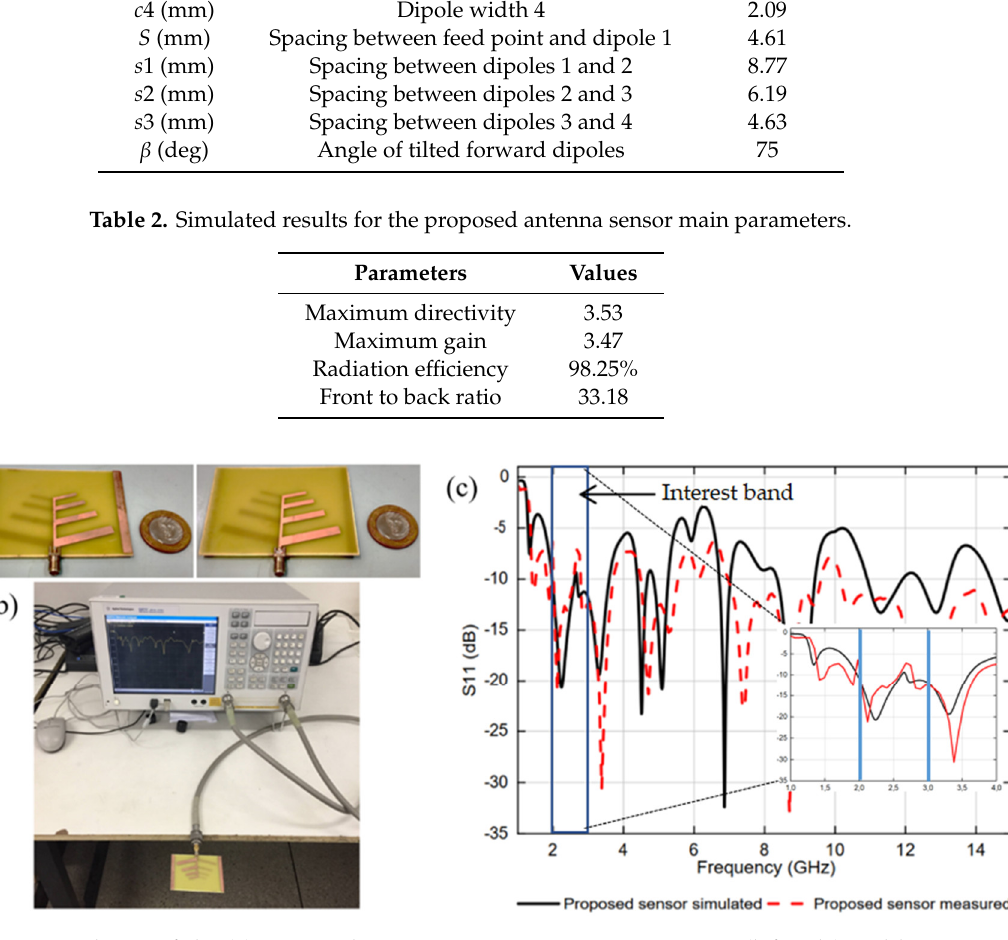
Table 2. Simulated results for the proposed antenna sensor main parameters.